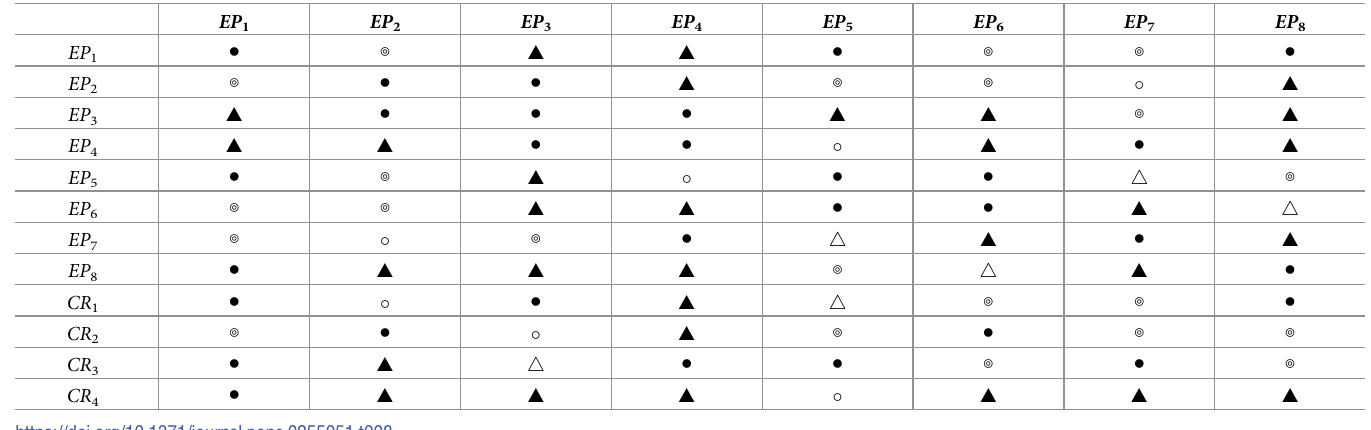
According to the importance symbols shown in Table 3, the correlation evaluation infor- mation of QFD in two stages given by experts is collected, as shown in Tables 8 and 9. In the first stage, the expert groups include market customer group (MC), process design group (DT), product manufacturing group (MT). Considering the limitation of market customer group knowledge background, in the second stage, the expert groups only include process design group (DT), product manufacturing group (MT). According to fuzzy sets, the evaluation information given by experts is transformed into corresponding fuzzy numbers. Eq (19) is used to obtain the fuzzy mean value of the correlation matrix and the autocorrelation matrix for multi-agent. In the first stage, the fuzzy matrix of the correlation matrix (CM) and the autocorrelation matrix (AM) are shown in Table 10. According to Table 10, the fuzzy evaluation information values (CM and AM) given by the DT expert group are obtained. Eq (21) is used to obtain the improved correlation CM � between multi-agent demands CR and engineering property indexes EP . And then, Eq (22) is used to obtain the absolute importance of engineering property indexes EW . Furthermore, we obtained the normalized importance of EW � by Eq (23). Due to the same calculation process and limited paper layout, the paper only gives the absolute importance and the normalized